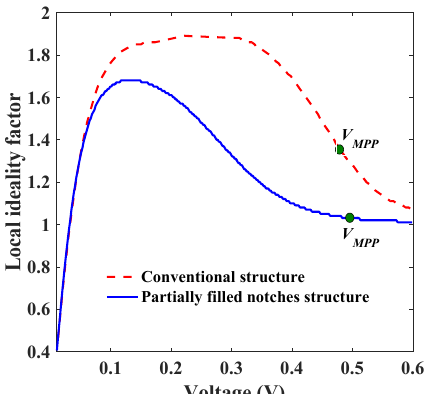
Figure 5. A comparison between the local ideality factor, derived from the dark J-V characteristics, of the conventional and modified structures.